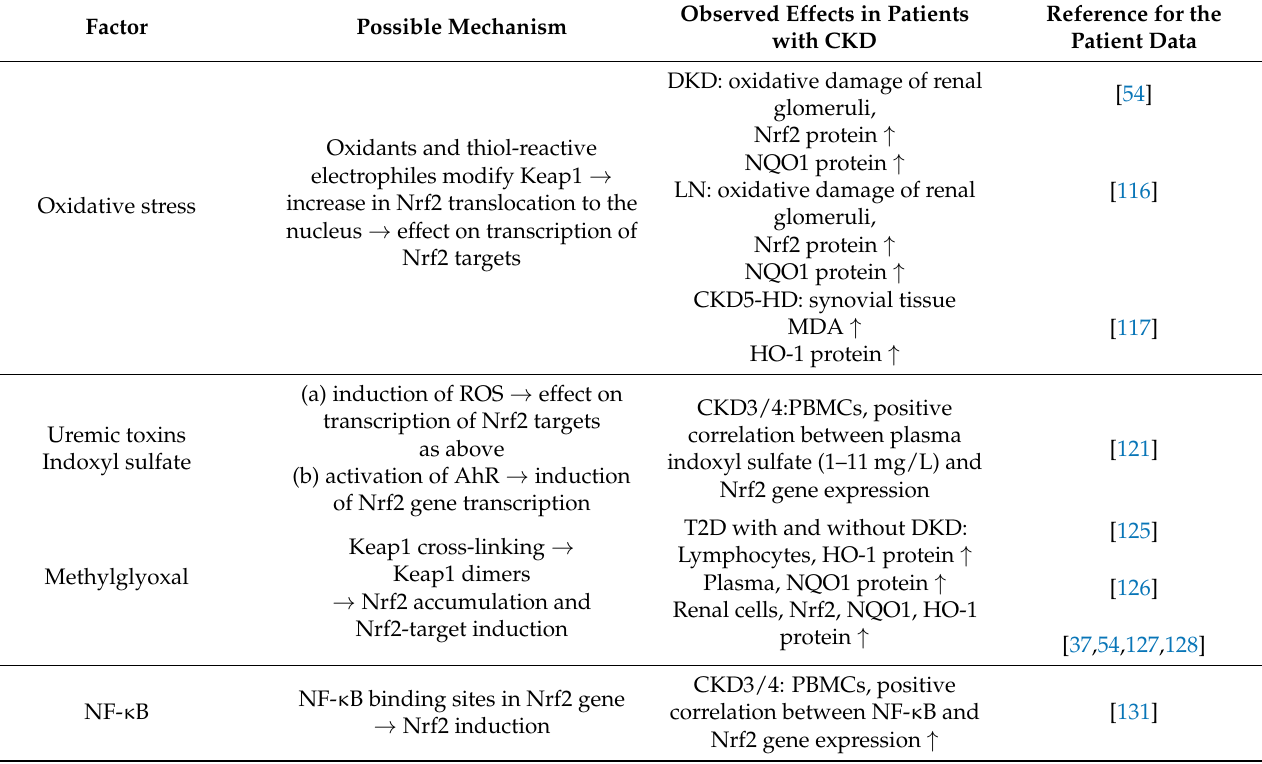
Table 1. Factors and mechanisms relevant for endogenous Nrf2 activation in human